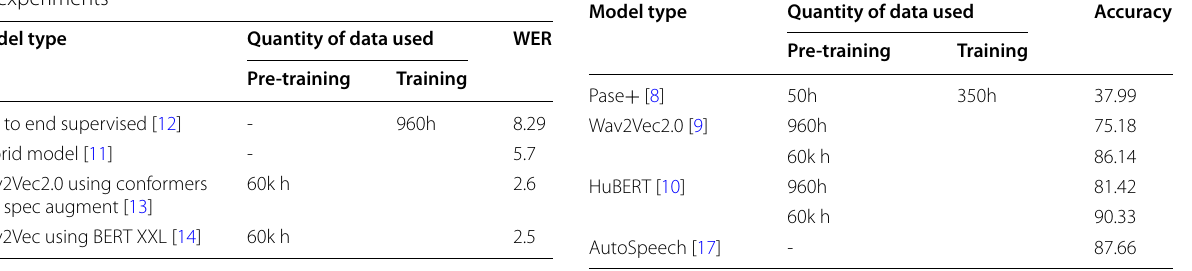
Table 2 SOTA results over test-other set from LibriSpeech and quantity of data used. Some self-supervised results come from [7] experiments